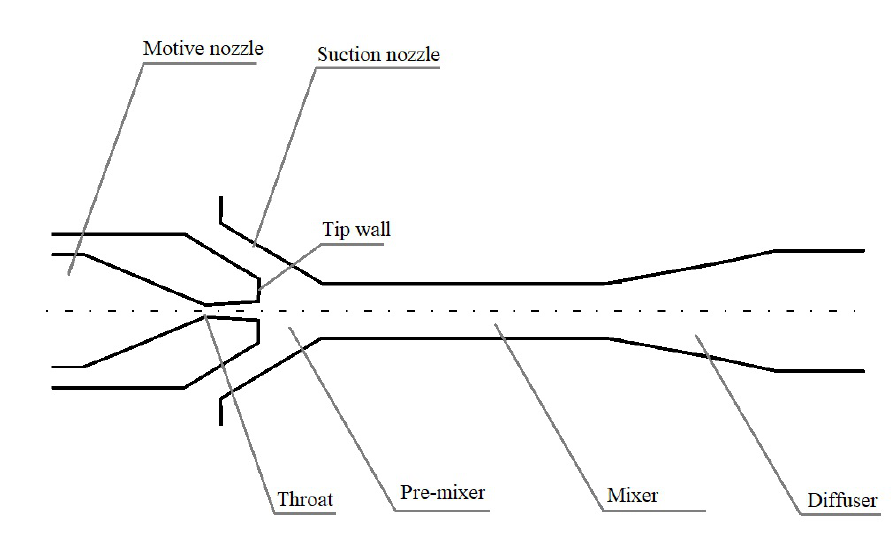
Figure 1. Geometry assembly of the R744 two-phase